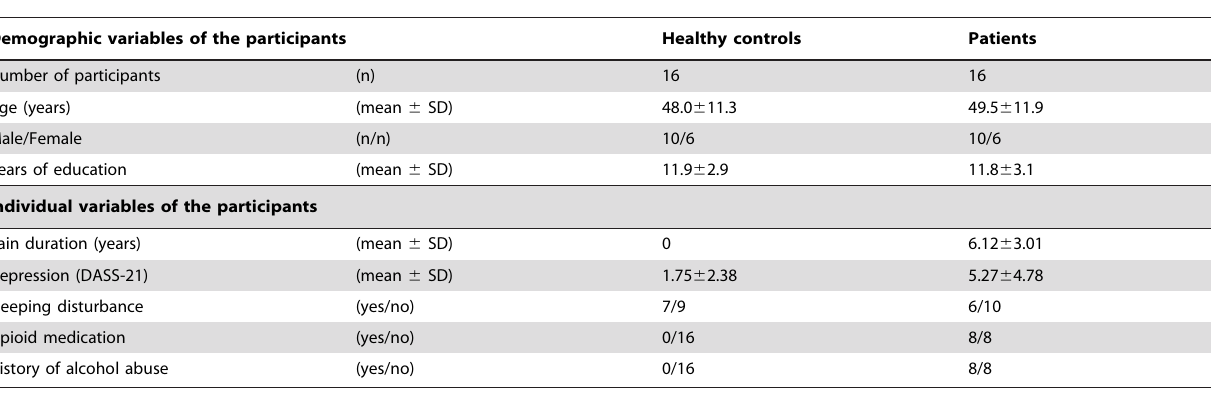
Table 1. Demographic and individual variables of the